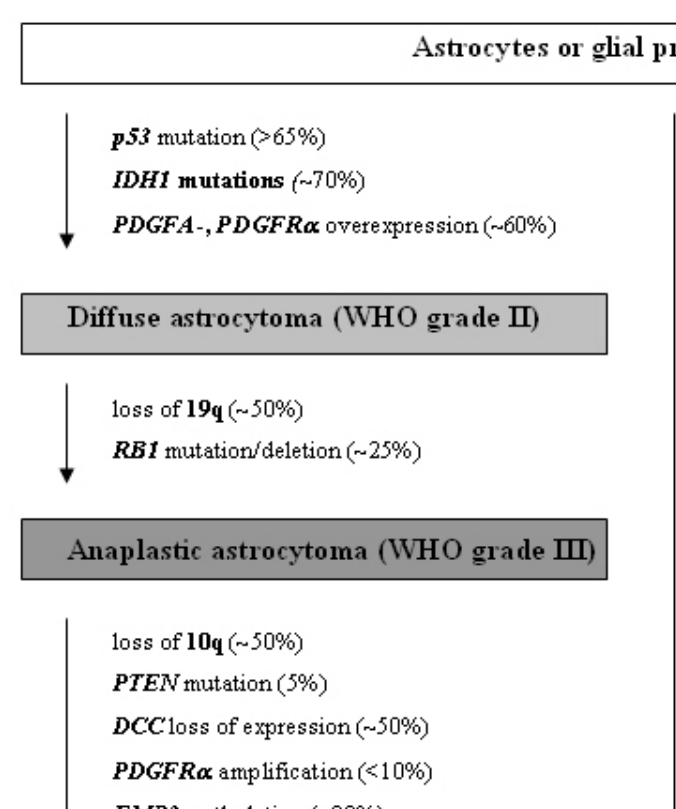
Figure 1 . Schematic representation of the molecular pathogenesis and progression of diffusely infiltrating astrocytic